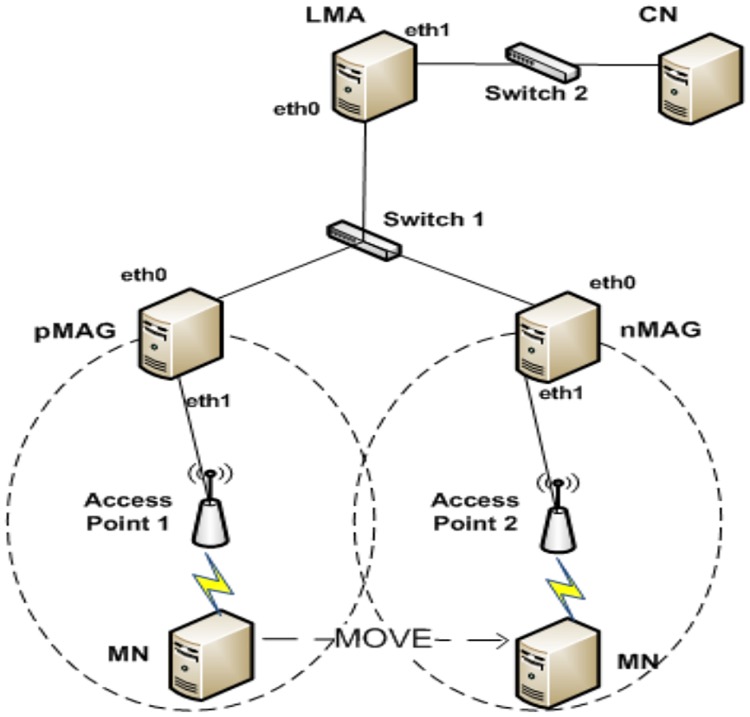
Network topology.